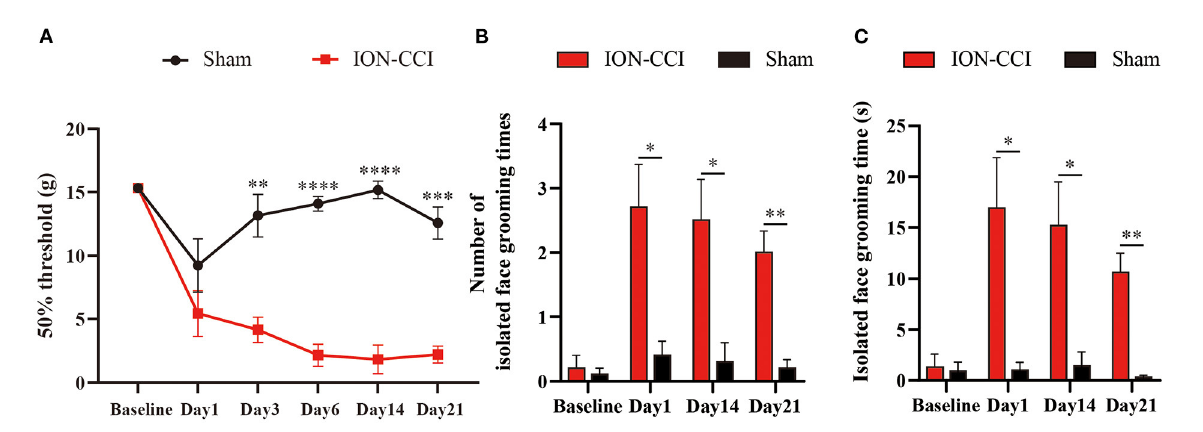
FIGURE5 Chronic neuropathic orofacial pain induced sensory hypersensitivity. (A) Rats displayed mechanical allodynia after establishment of ION-CCI. N = 6; ** p < 0.01, *** p < 0.001, **** p < 0.0001, Two-way ANOVA with repeated measures and Bonferroni’s post-test. (B,C) ION-CCI Rats developed spontaneous pain-like behavior, as demonstrated by increasing isolated grooming behavior. N = 10; * p < 0.05, ** p < 0.01, Two-way ANOVA with repeated measures and Bonferroni’s post-test.